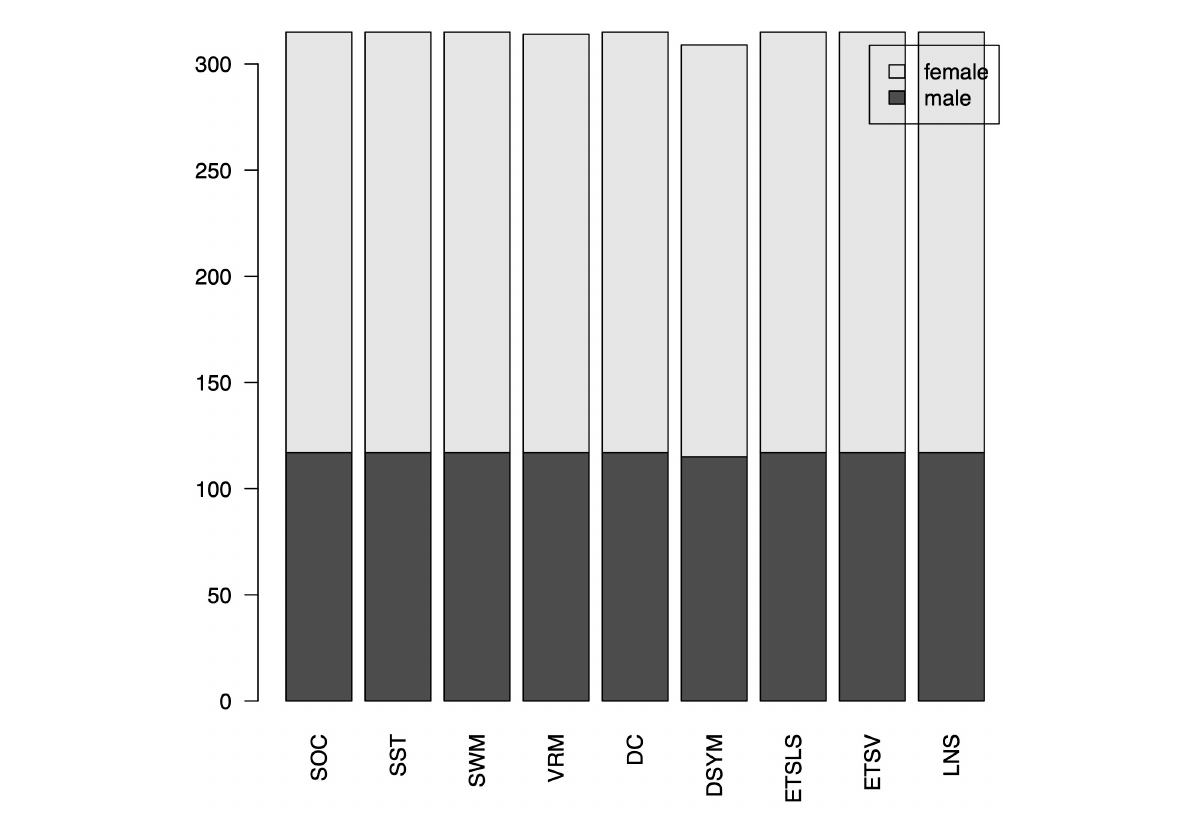
FIGURE7 Gender distributions for the nine cognitive